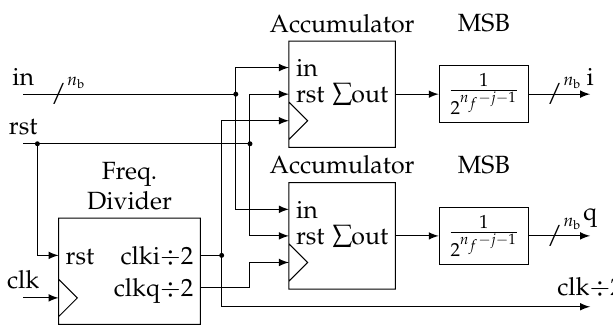
Figure 8. Details of the “Demodulator” generic block.